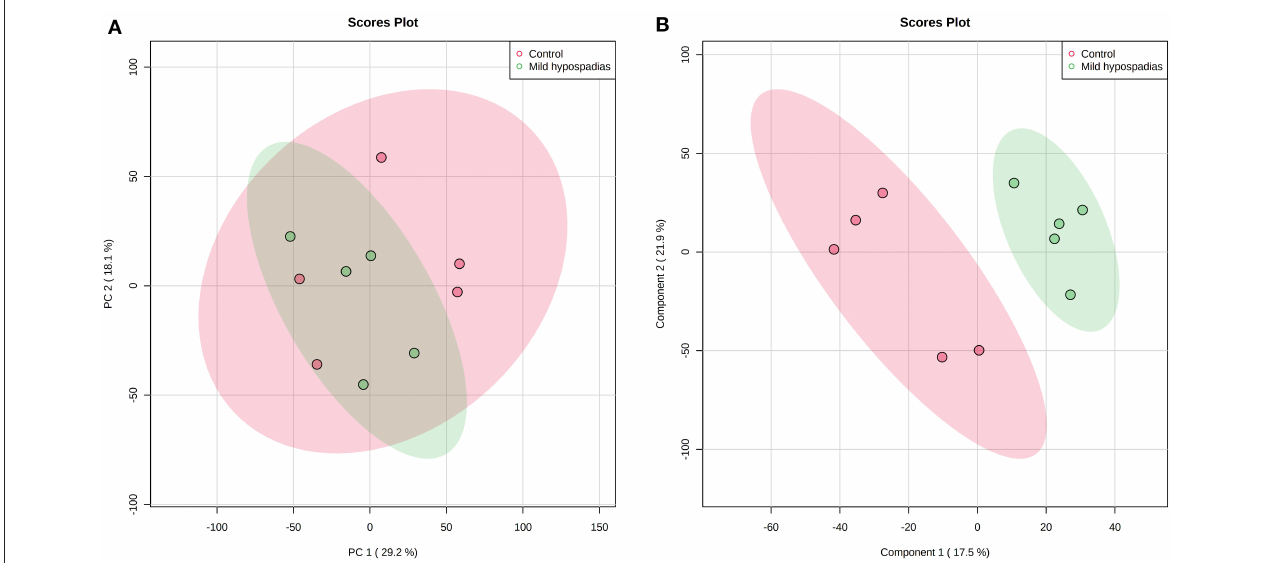
FIGURE 2 | Mild hypospadias protein profile differs from controls. Zq values from a total of 2,522 proteins identified with two or more peptides were subjected to PCA and PLS-DA. (A) Score plot for PC1 (29.2% variance explained) vs. PC2 (18.1% variance explained). (B) Score plot for PLS1 (17.5% variance explained) vs. PLS2 (21.9% variance explained). The ellipses illustrate 95% confidence region for these groups. n =